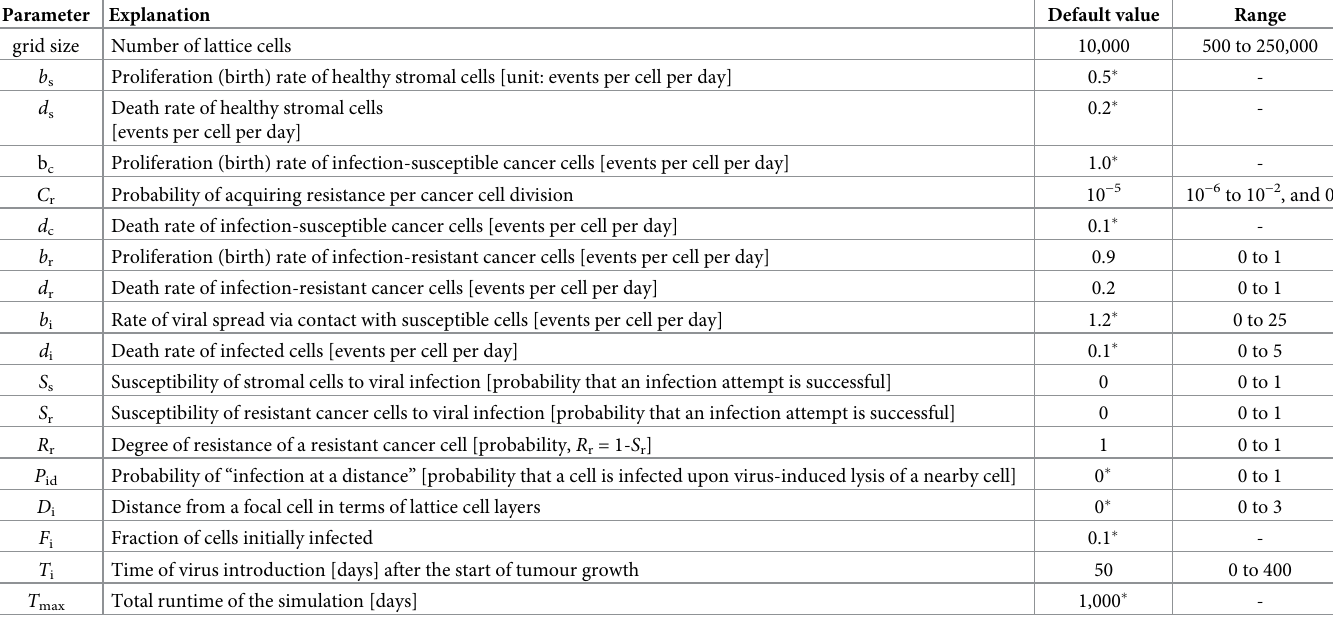
Table 1. Model parameters, their default values, and the range of values investigated in the simulations. Parameter values marked by a star are adapted from Berg et al. [15]. Parameter Explanation grid size b s Proliferation (birth) rate of healthy stromal cells [unit: events per cell per day] d s Death rate of healthy stromal cells [events per cell per day] b c Proliferation (birth) rate of infection-susceptible cancer cells [events per cell per day] C r Probability of acquiring resistance per cancer cell division Death rate of infection-susceptible cancer cells [events per cell per day] b r Proliferation (birth) rate of infection-resistant cancer cells [events per cell per day] d r Death rate of infection-resistant cancer cells [events per cell per day] b i Rate of viral spread via contact with susceptible cells [events per cell per day] d i Death rate of infected cells [events per cell per day] S s Susceptibility of stromal cells to viral infection [probability that an infection attempt is successful] S r Susceptibility of resistant cancer cells to viral infection [probability that an infection attempt is successful] R r Degree of resistance of a resistant cancer cell [probability, R r = 1- S r ] P id Probability of “infection at a distance” [probability that a cell is infected upon virus-induced lysis of a nearby cell] Distance from a focal cell in terms of lattice cell layers Fraction of cells initially infected Time of virus introduction [days] after the start of tumour growth T max Total runtime of the simulation